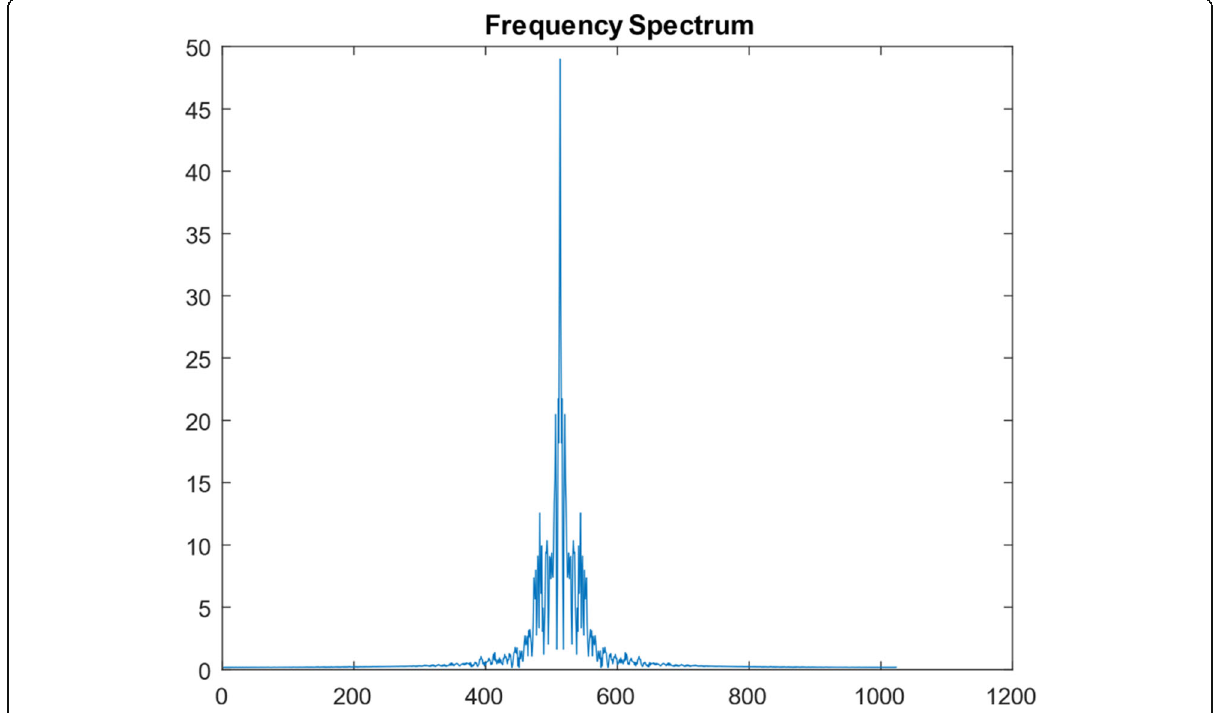
Fig. 6 The frequency spectrum of the true ‘ random ’ function